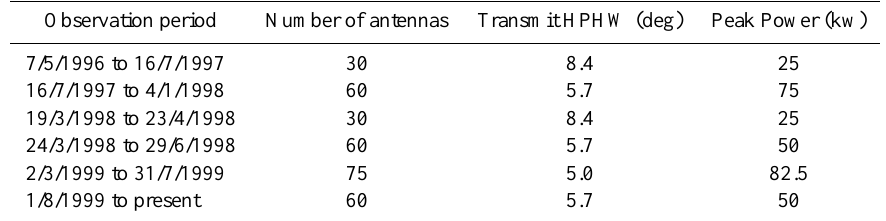
Table 1. Observation periods for routine Spaced Antenna (SA) analysis for the Buckland Park MF